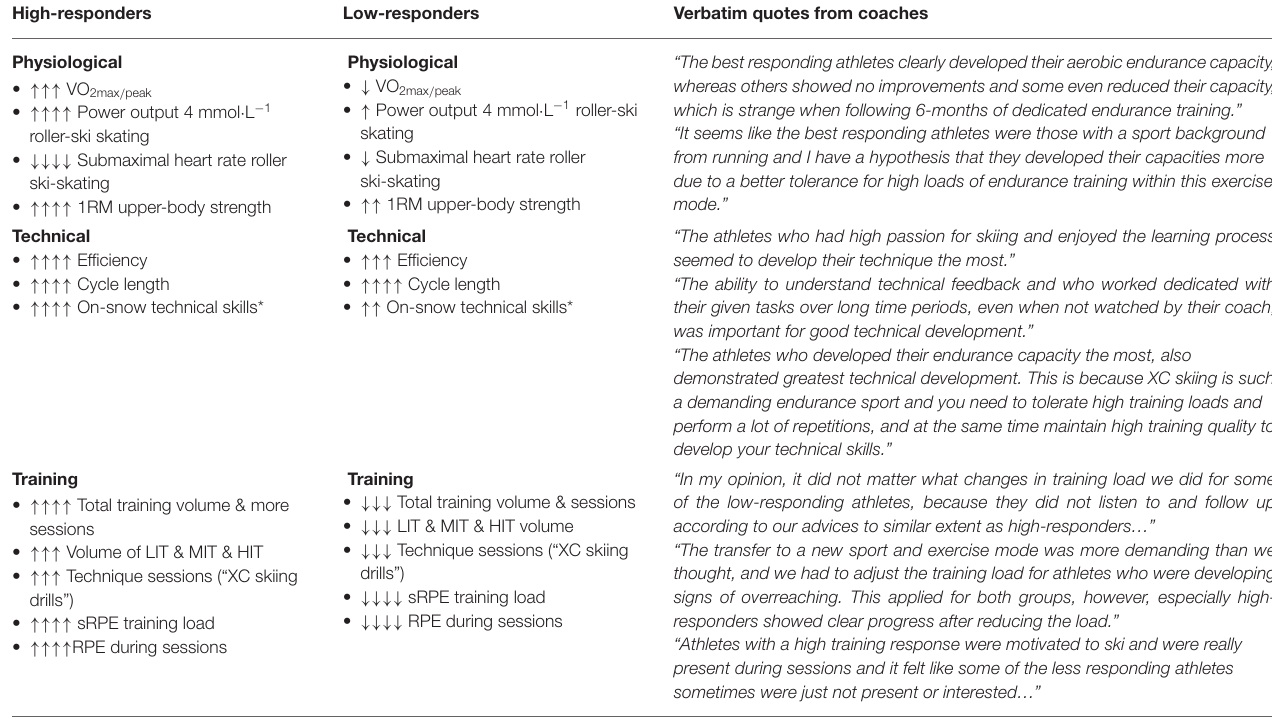
TABLE 3 | Multidisciplinary overview of physiological, technical and training related factors differentiating high- from low-responders following 6-months of XC ski-specific training in a group of endurance transfer athletes including direct verbatim quotes from the athlete’s personal coaches.